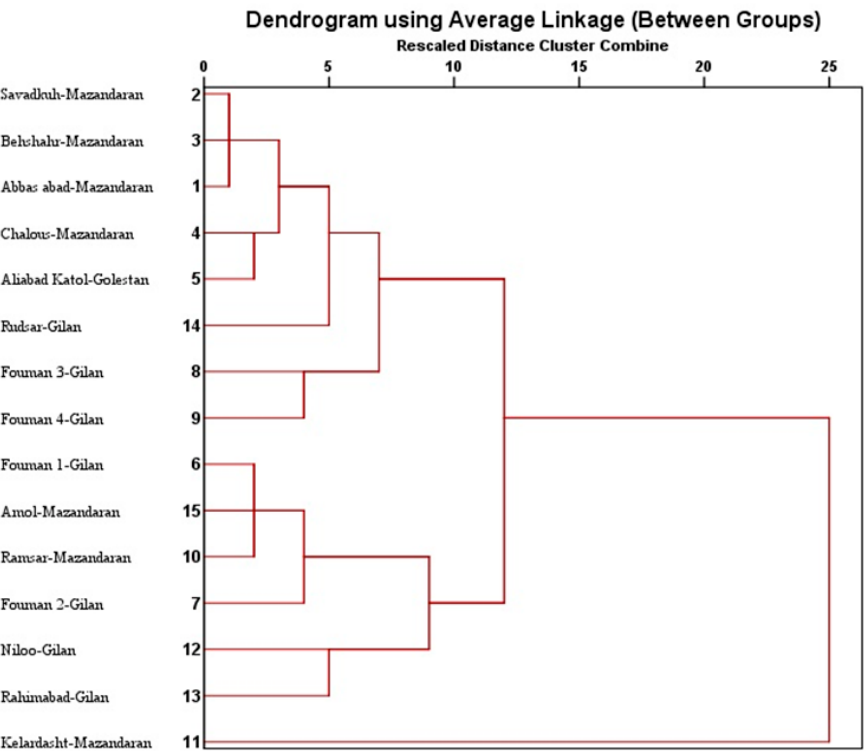
Figure 8. Dendrogram of cluster analysis for morphological traits of M. aquatica populations from the Hyrcanian hotspot of Iran.